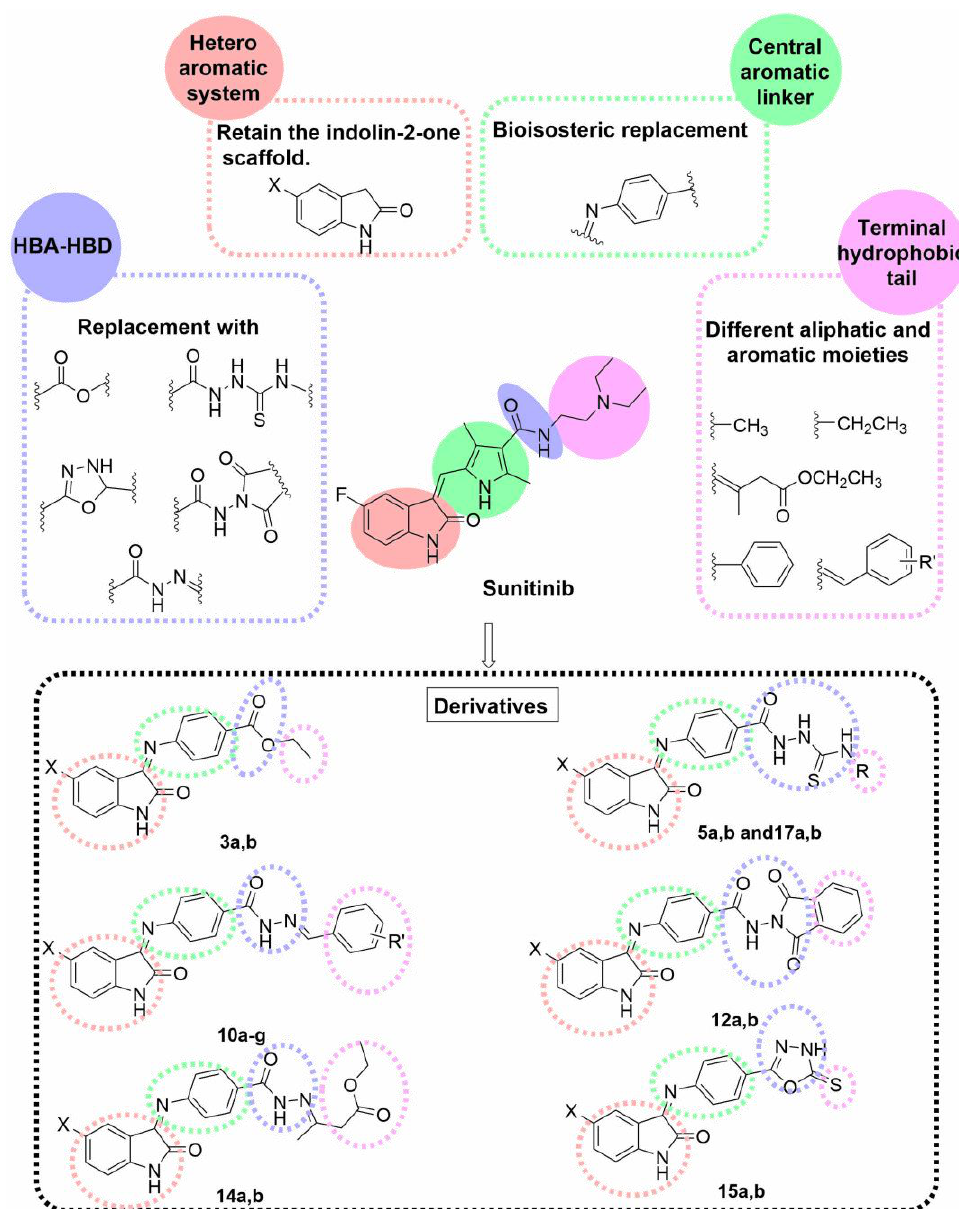
Figure 3. Rationale of the designed compounds based on the pharmacophore model of VEGFR-2 inhibitors and using sunitinib as a lead compound.